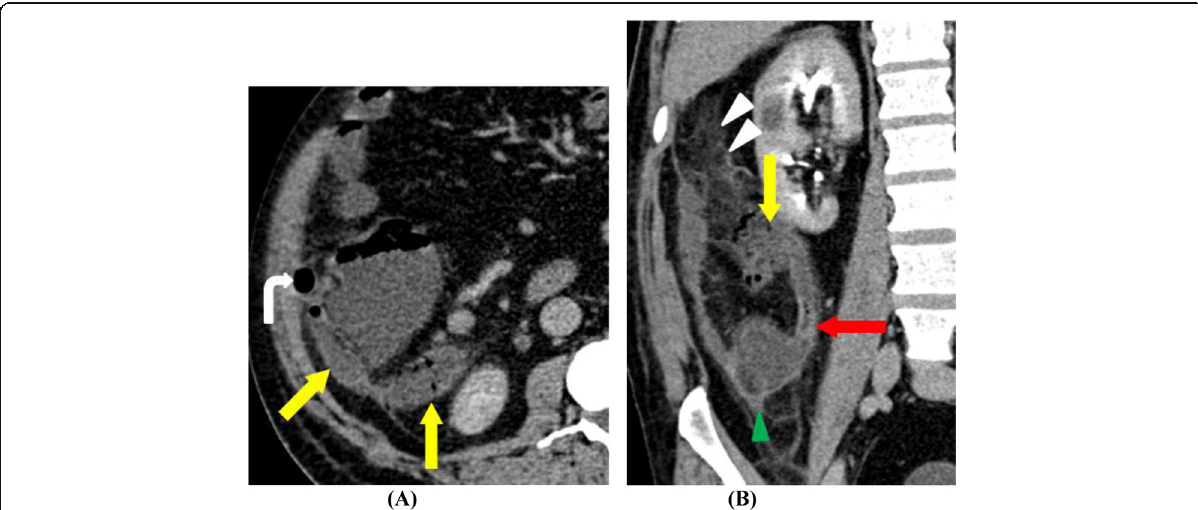
Fig. 13 Acute perforated appendicitis with abscess formation in a 66-year-old male patient presented with acute right iliac fossa pain, vomiting, and fever. Focused CT axial ( a ) and focused coronal ( b ) images following water enema and intravenous contrast injection CT abdomen and pelvis, showing inflamed appendix (red arrow) with its tip is seen continuous with an abscess containing gas bubbles (yellow arrows), free gas is seen at the